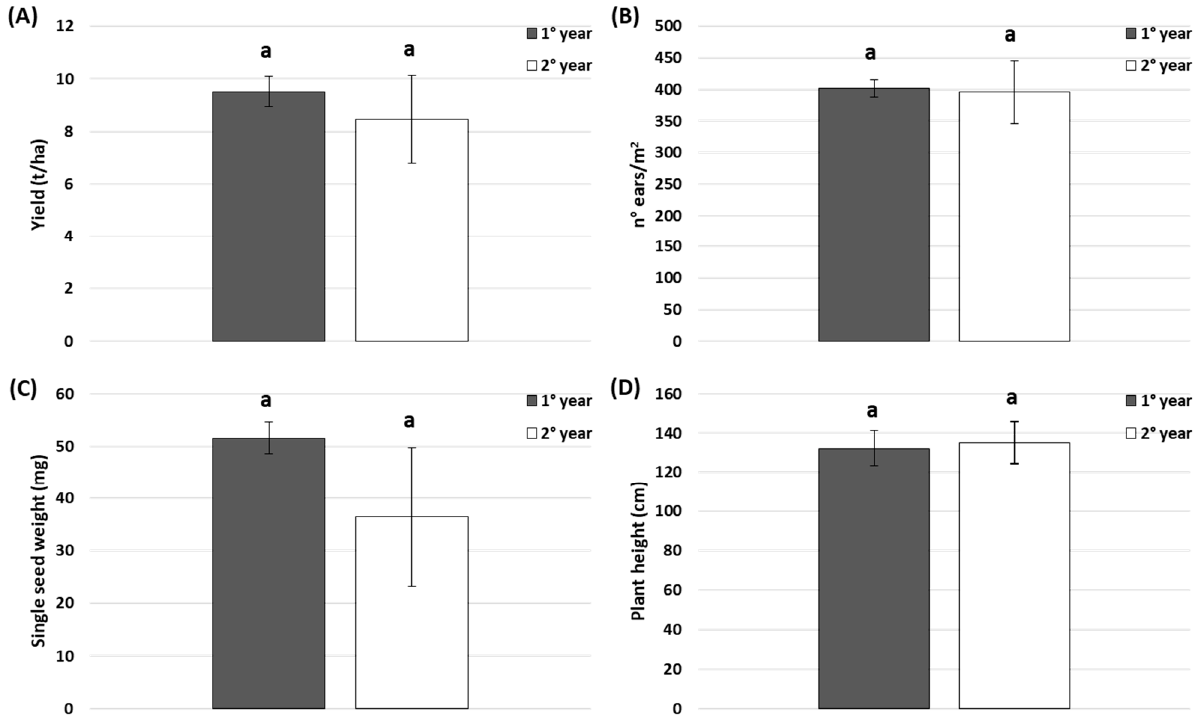
Figure 4. The measured yield ( A ), n°ears/m 2 ( B ), single-seed weight ( C ) and plant height ( D ) of Alpina rye in Valleggia ( t -test, p < 0.05).